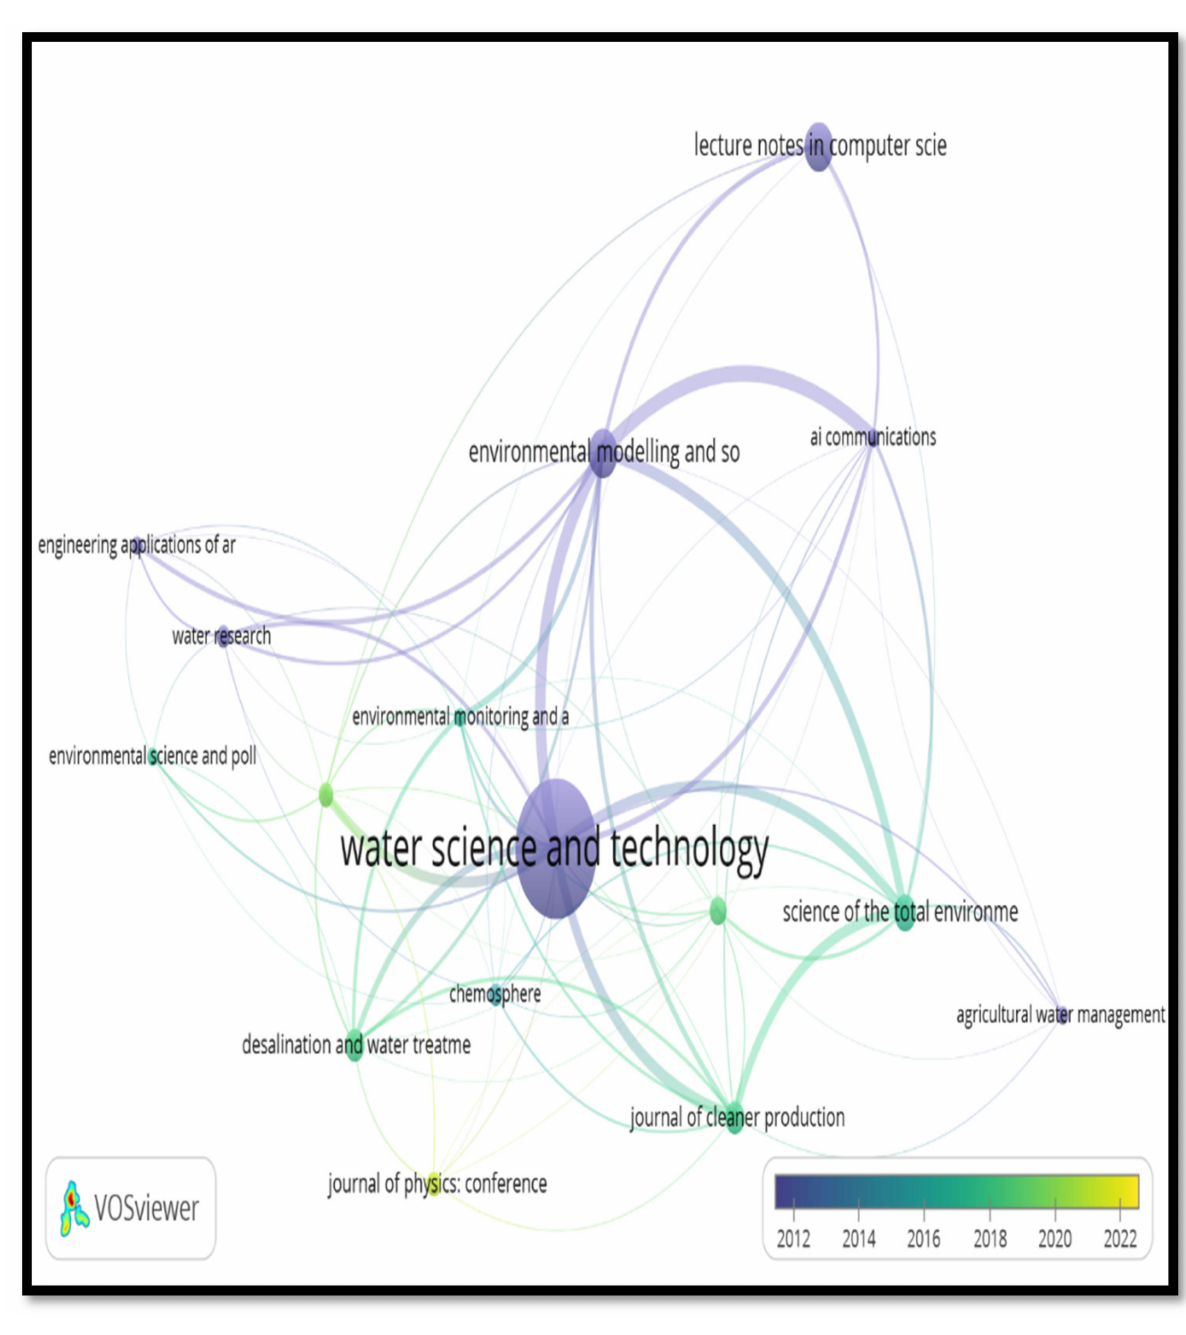
Figure 14. Journals with significant numbers of artificial intelligence models for wastewater treatment articles generated using VOSviewer. VOSviewer network visualization map of Journals using the keyword “artificial intelligence models for wastewater treatment,” data collected from Scopus between 2012 and